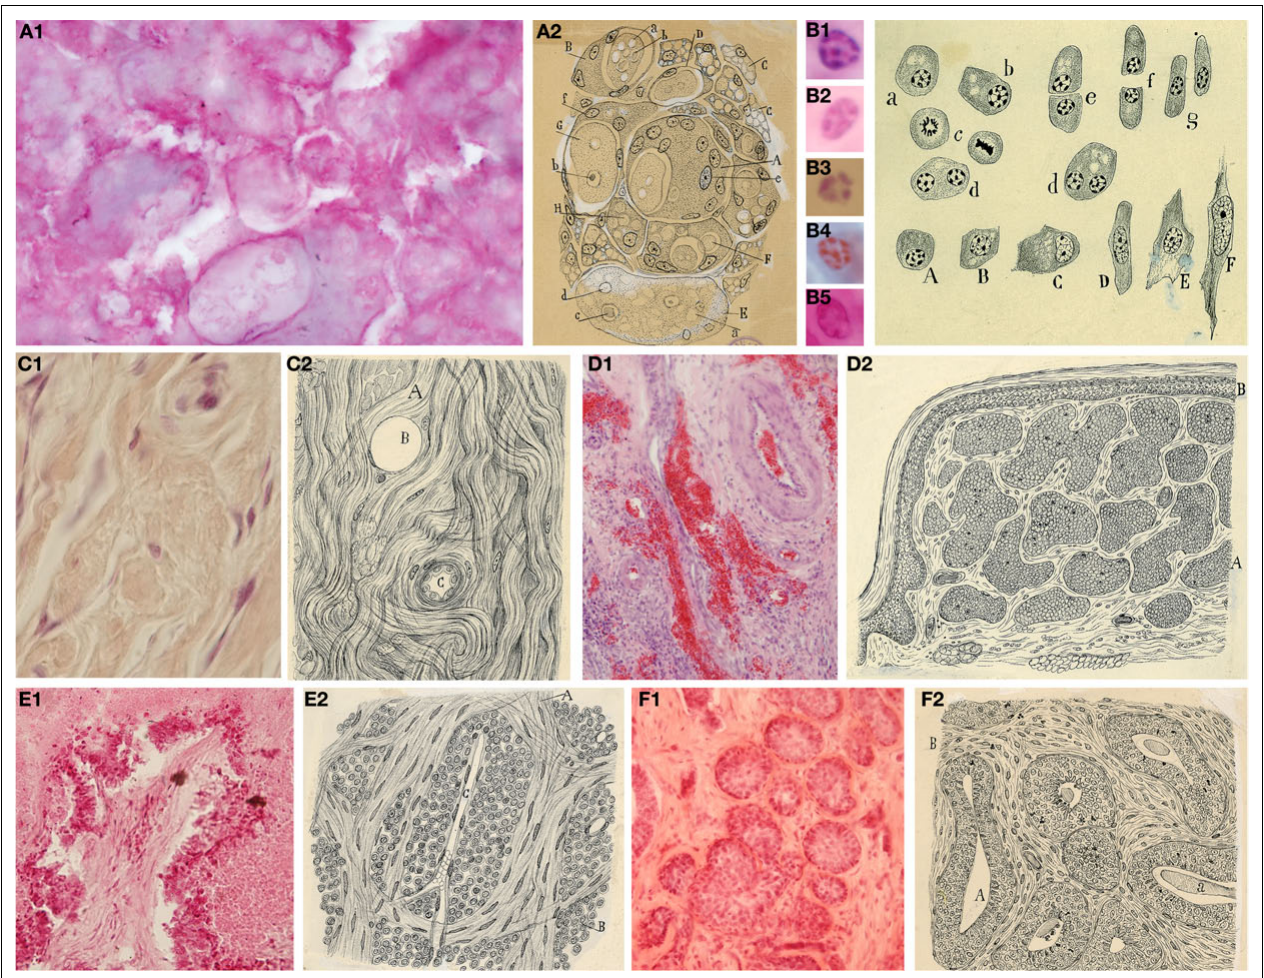
FIGURE 10 | Cajal’s histological preparations and drawings about pathology. (A) Syphilitic chancre; (B) Plasma cells in connective tissue of tumor; (C) Infi ltrating carcinoma of the nose; (D) Cavernous angioma of the skin; (E) Alveolar